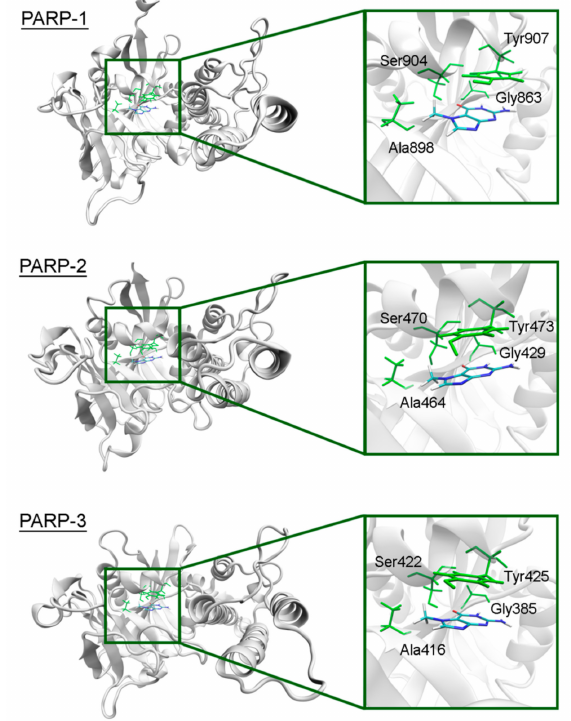
Figure 3. 7-MG position in the NA binding site of PARPs 1–3 obtained using MD modeling. The NA site residues are colored in green.